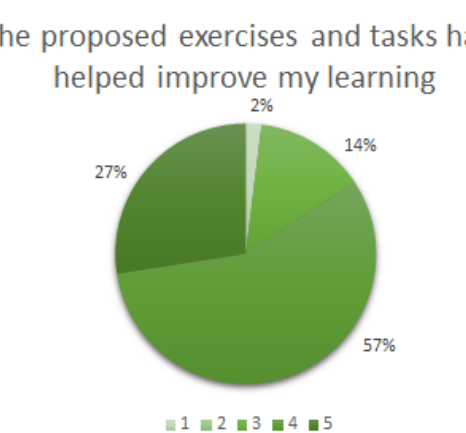
Figure 6. Students’ perceptions of assertion